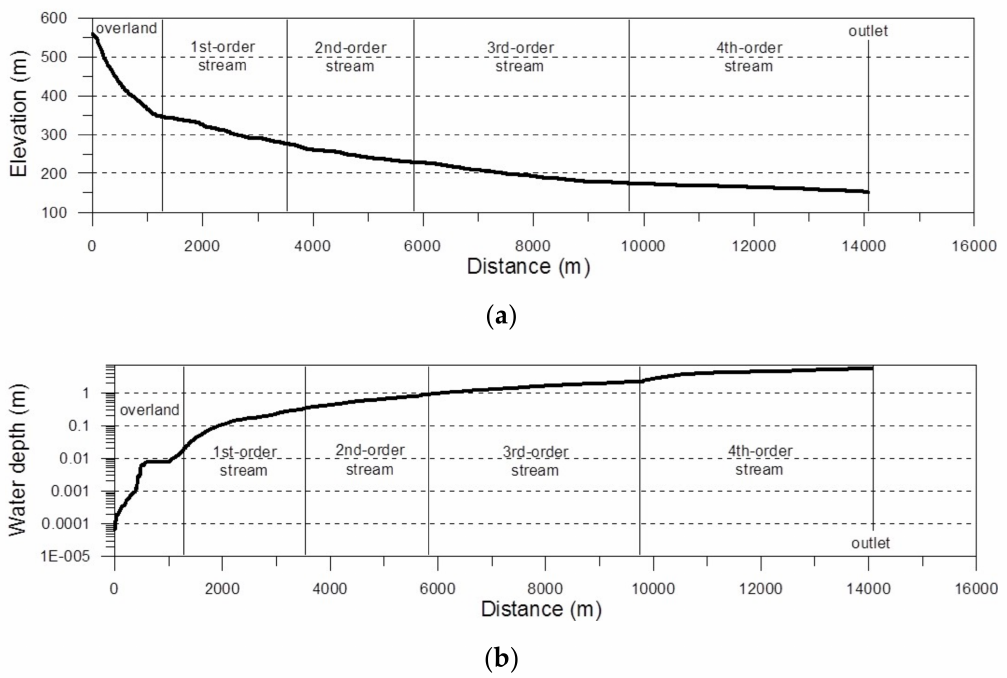
Figure 12. Ground bed elevation and the greatest water depths along the longest drainage path during the simulation of the storm occurring on 16 August 1968, ( a ) Elevation of ground bed; ( b ) Greatest water